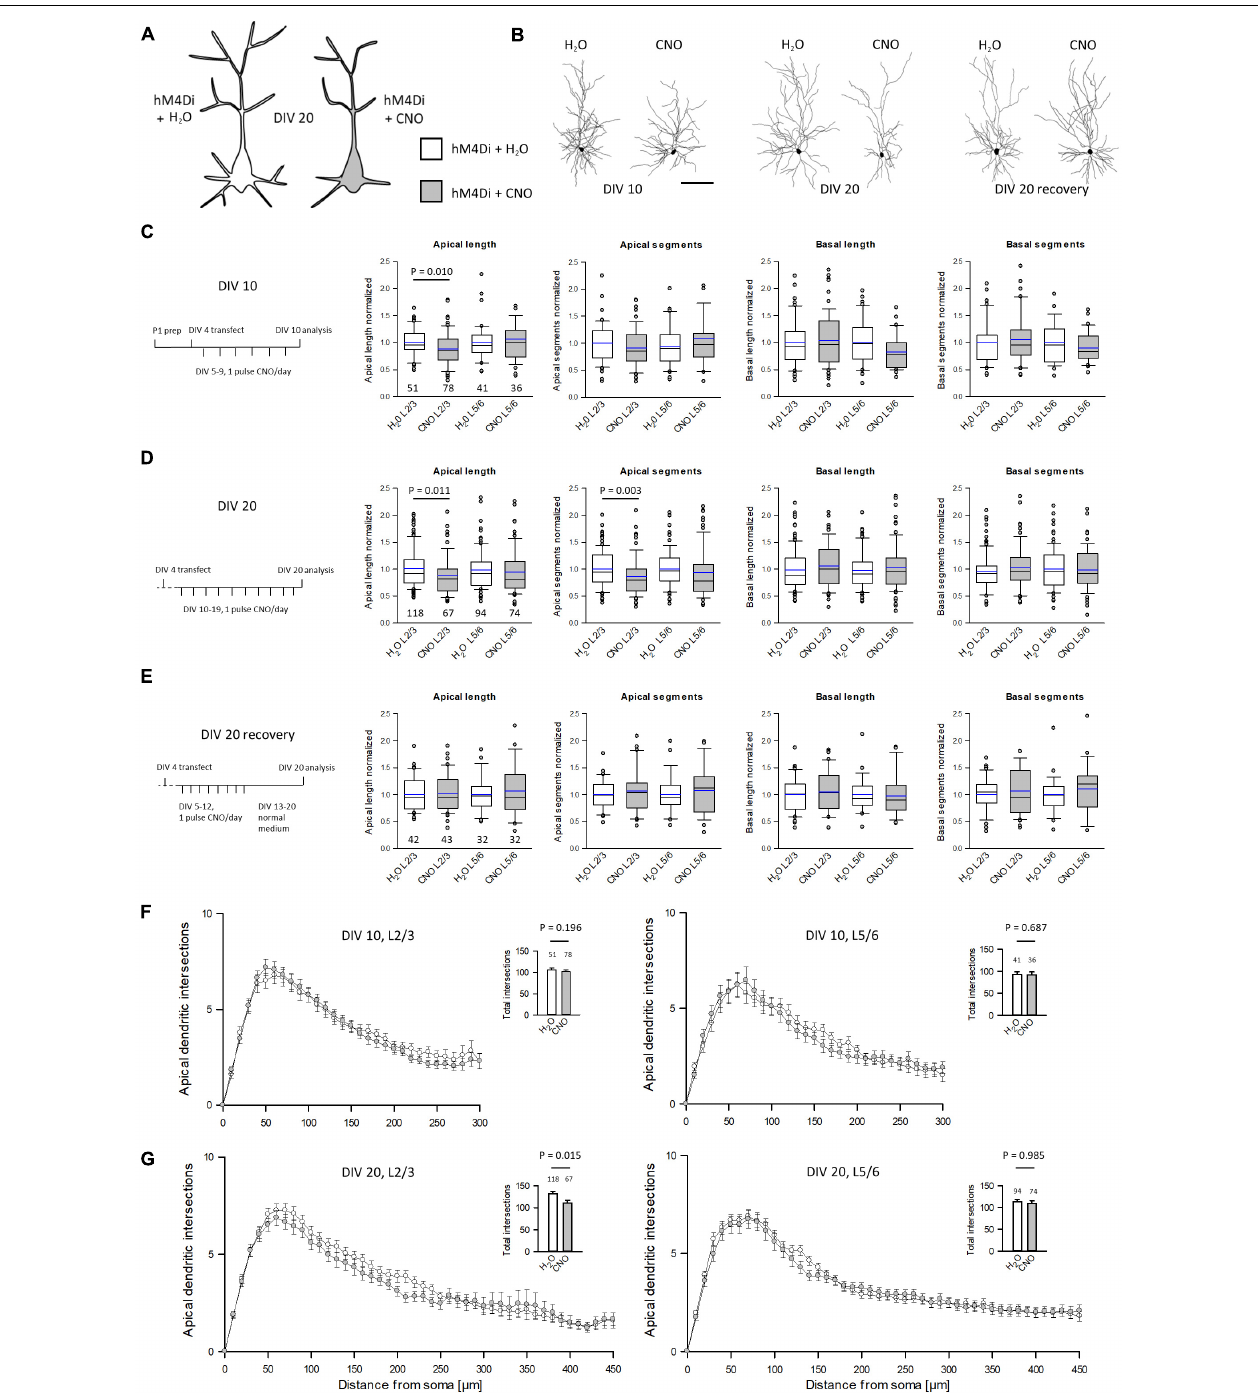
FIGURE 3 | Prolonged reduction of activity via hM4Di reduces apical complexity of supraganular pyramidal cells. (A) Prolonged activation of hM4Di was hypothesized to reduce dendritic complexity. (B) Skeletal drawings of control (left) and CNO-stimulated (right) L2/3 pyramidal cells at DIV 10, DIV 20 and DIV 20 recovery. (C) Stimulation protocol and morphometric analysis of L2/3 and L5/6 pyramidal cells at DIV 10. (D) Stimulation protocol and morphometric analysis of L2/3 and L5/6 pyramidal cells at DIV 20. (E) Stimulation protocol and morphometric analysis of L2/3 and L5/6 pyramidal cells at DIV 20 after recovery. Values were normalized to the average of batch-internal control cells. Black lines in the box plots represent the median and blue lines indicate the mean. (F) Sholl analysis and total intersections of L2/3 and L5/6 pyramidal cell apical dendrites at DIV 10. (G) Sholl analysis and total intersections of L2/3 and L5/6 pyramidal cell apical dendrites at DIV 20. Numbers of analyzed neurons are given below the box plots or above the bars. Statistics: Mann–Whitney rank sum test H 2 O control vs. CNO, P -values are reported. Scale bar in panel (B) 100 µ m.